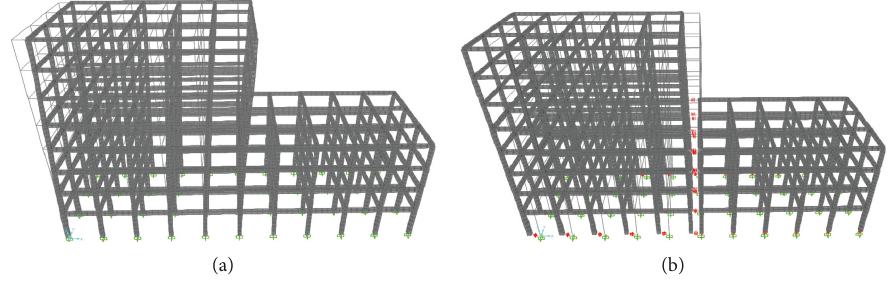
Figure 6: First modal response of the adjacent structures. (a) FFB adjacent buildings. (b) FBI adjacent buildings.